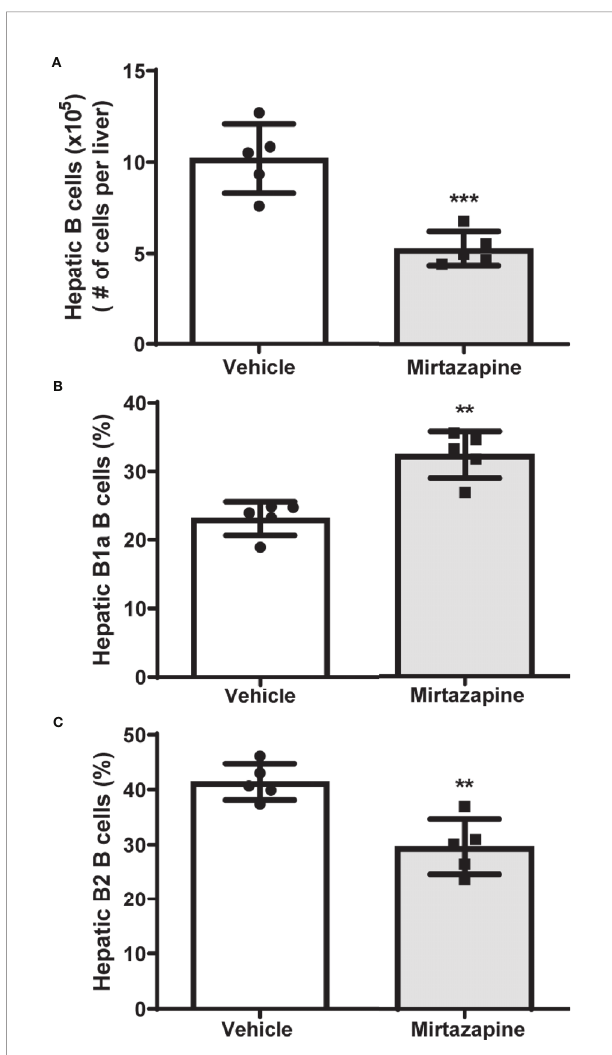
FIGURE 1 | Mirtazapine treatment signi fi cantly decreases hepatic B cell numbers and induces compositional changes in hepatic B cell subtypes. (A) Administration of mirtazapine resulted in ~ 2-fold reduction in numbers of hepatic B cells 5 hrs post-Mirtazapine administration vs vehicle treated mice (***p ≤ 0.0008 n = 5 mice/group). (B) B1a B cells are signi fi cantly enriched within the livers post-mirtazapine treatment (**p ≤ 0.001; n = 5 mice/group). (C) Hepatic B2 cells are signi fi cantly reduced in mirtazapine-treated vs. vehicle-treated treated mice (**p ≤ 0.004; n = 5